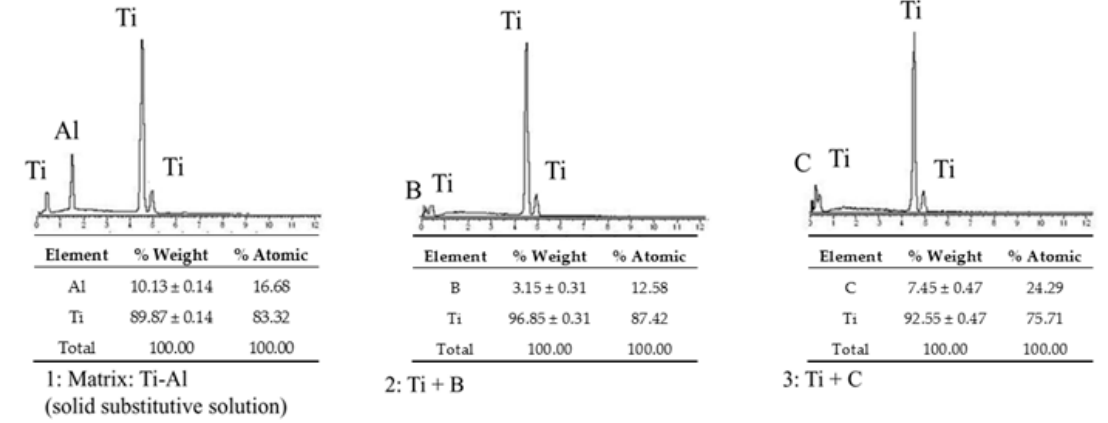
Figure 5. EDS analyses in principal spots at 1400 °C.